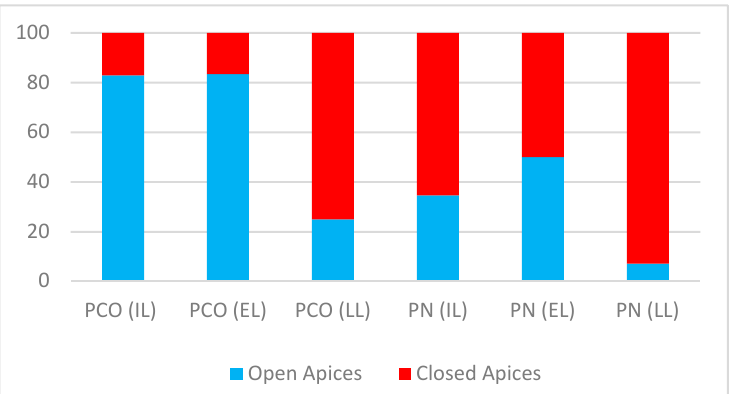
Figure 3. The figure shows the percentage rates of pulp necrosis (PN) and pulp canal obliteration (PCO) in intrusive luxation (IL), extrusive luxation (EL), and lateral luxation (LL).